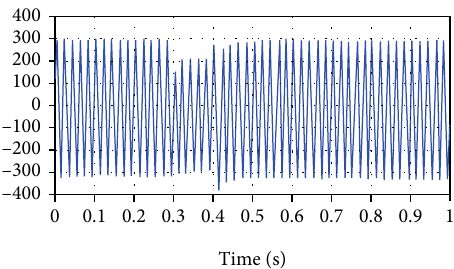
at the terminals of sensitive load after L